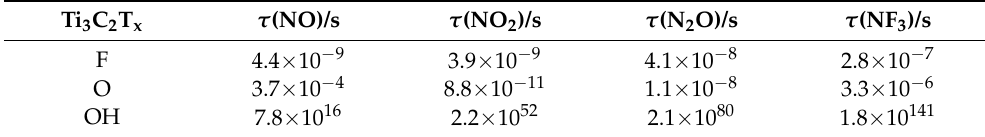
Table 3. Recovery time at room temperature (25 ◦